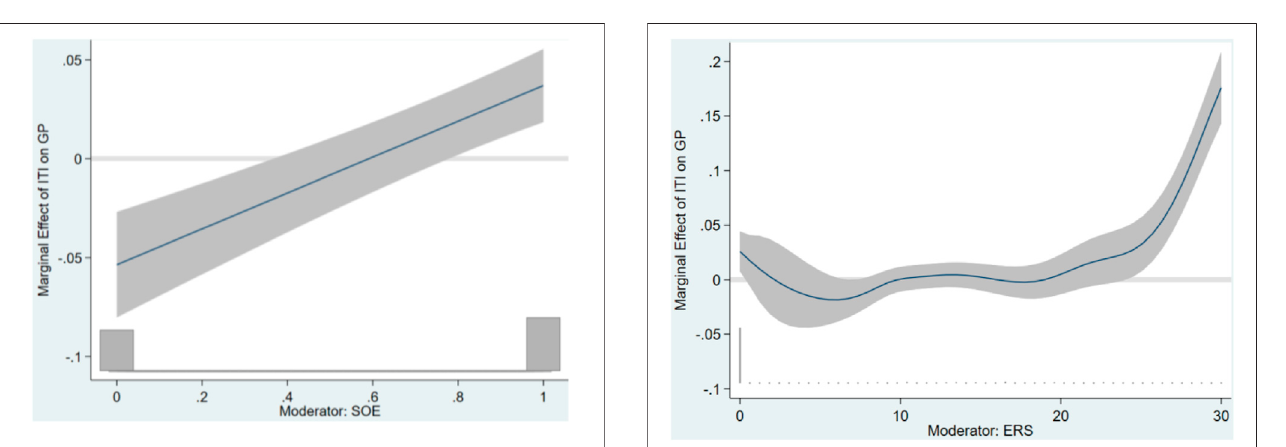
FIGURE 3 | Effects of environmental responsibility.